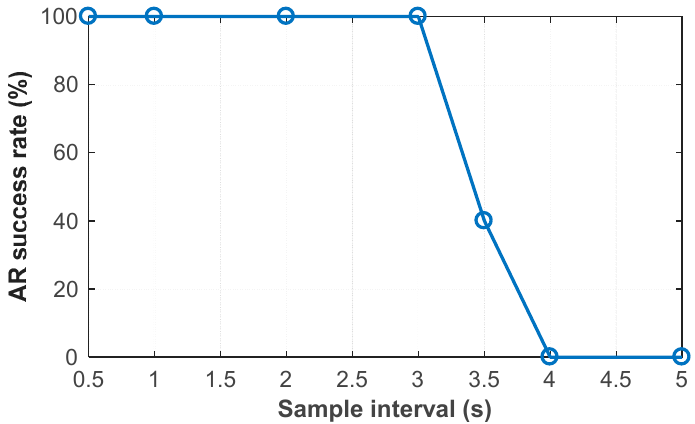
Figure 16. Statistical success rates as function of the sample interval.